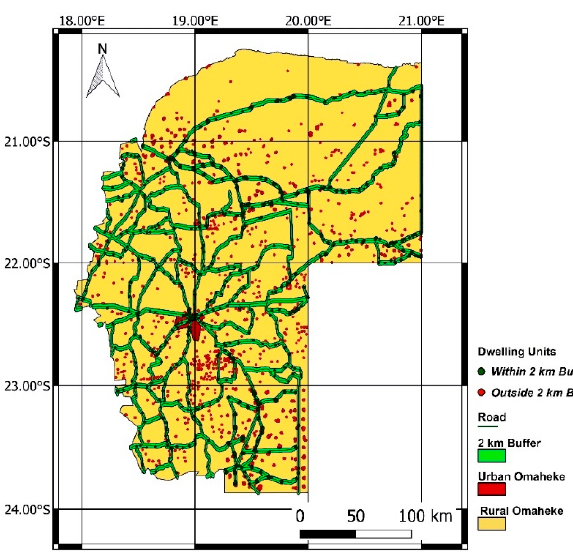
Figure 13. Rural Omaheke Dwelling Units 2011—within 2 km road buffer zone.